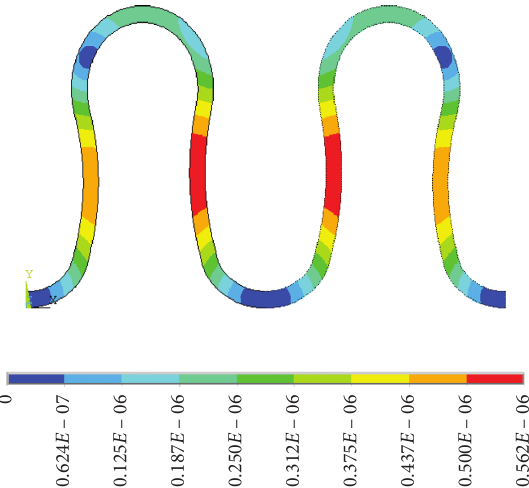
Figure 13: Deformation distribution at air inlet and gas outlet side considering thermal stress (m).